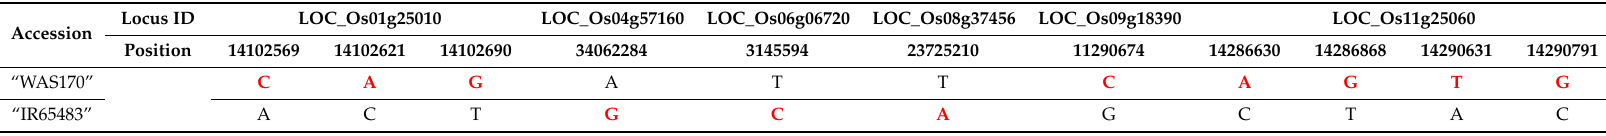
Table 2. Allelic di ff erences between rice accessions “WAS170” (short-lived) and “IR65483” (long-lived) on six flavonol synthase genes regulating flavonols accumulation. Red font indicates non-synonymous